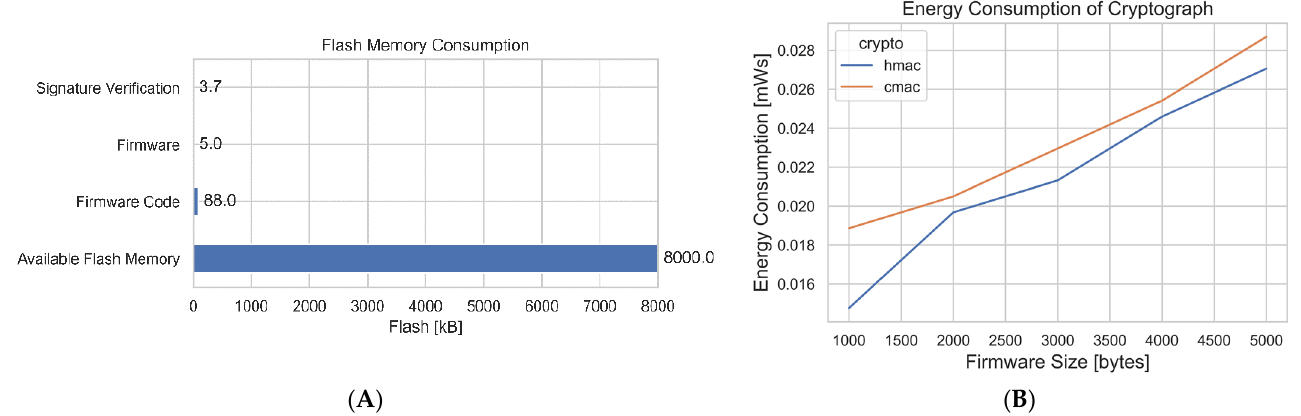
Figure 23. ( A ) Flash Memory Consumption and ( B ) Crypto Energy Consumption.